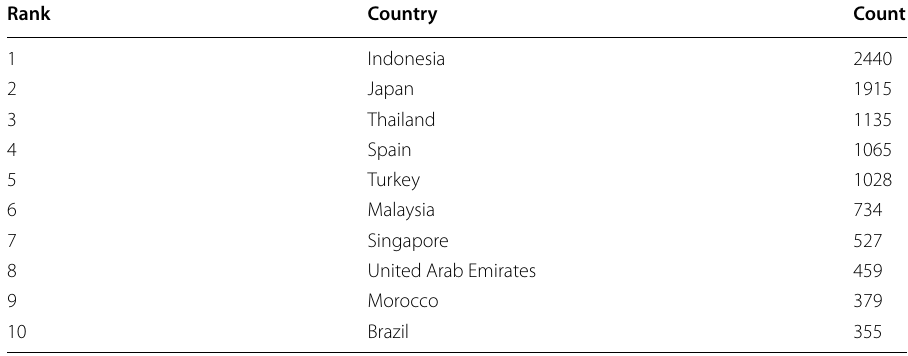
Table 2 The top 10 most repeated countries